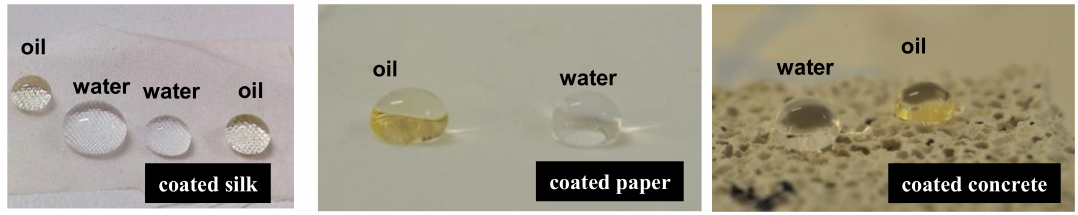
Figure 3. Water and oil drops on various materials which were coated by Silres +